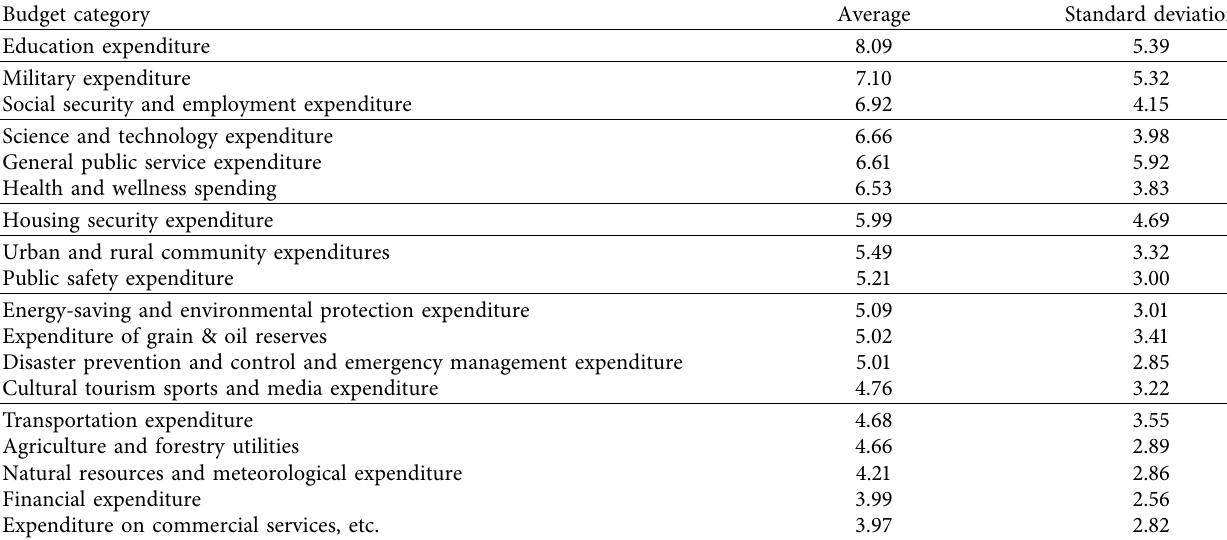
Table 4: Descriptive statistics of overall budget category (unit: RMB 1